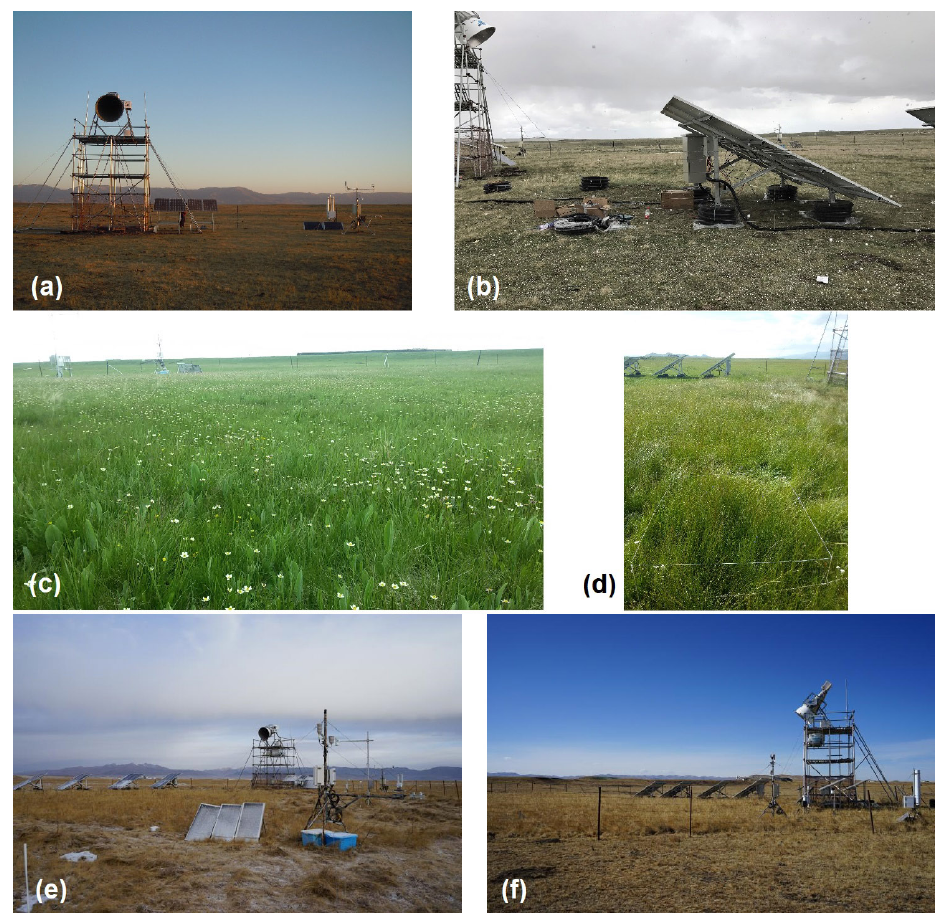
Figure A1. Maqu site changing phenology. (a) Winter, January 2016. (b) Spring, 16 May 2017. (c) Spring, 26 June 2018. (d) Summer, 17 August 2018. (e) Winter, 6 January 2018. (f) Winter, 6 January 2018.